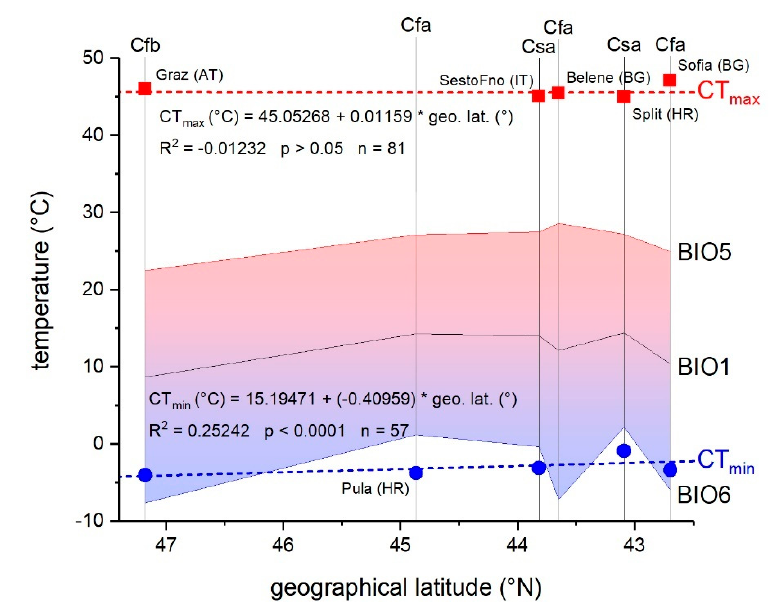
Figure 4. Thermal tolerance breadth (CT max − CT min ) of Pyrrhocoris apterus as well as bioclimatic variables BIO1 (mean annual temperature), BIO5 (maximum temperature of warmest month), and BIO6 (minimum temperature of coldest month) at the sample sites in dependence on geographical latitude. Table 5. Statistical analysis of phylogenetic signal in fresh body mass, CT min , CT max , TTB (thermal tolerance breadth), TC (cold tolerance), and TH (heat tolerance). Estimation of phylogenetic signals for single traits with Pagel’s λ : p ( λ = 0) states the significance level of “no phylogenetic signal”, and P ( λ = 1) the significance level of “a strong phylogenetic signal. In the case of body mass, for example, p ( λ = 0) < 0.001 means that the hypothesis of no phylogenetic signal was discarded, and P ( λ = 1) = 1 means that the hypothesis of a strong phylogenetic signal was confirmed (i.e., is not discarded).